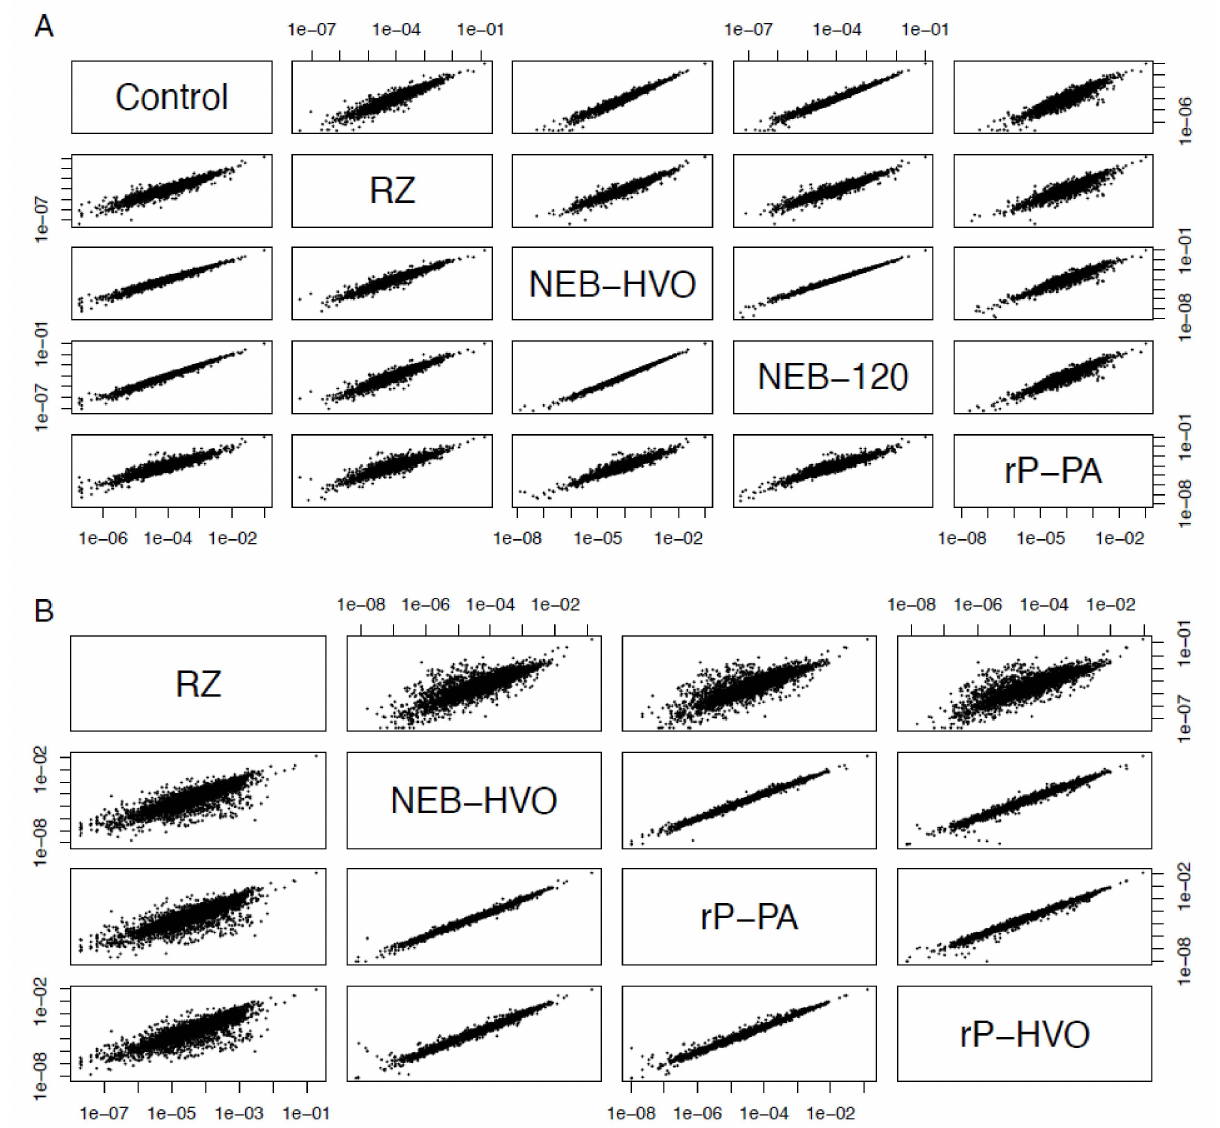
Figure 7. Choice of removal method does not affect relative abundance of mRNAs. Correlations between relative abundance of each gene after different rRNA removal methods in ( A ) Hbt. salinarum (HBT) and ( B ) Hfx. volcanii (HVO). Each dot represents the percent of total normalized reads for each gene (see Methods section). Methods shown here are “Control” (no removal), “RZ”